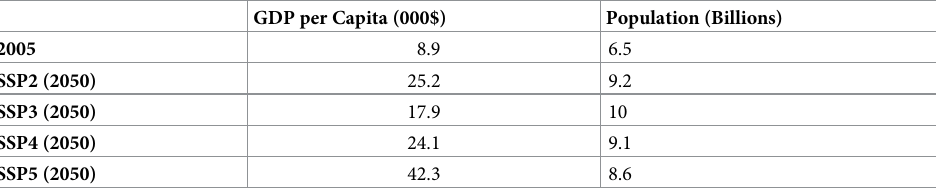
Table 2. Global average GDP per capita and population values for the IMPACT model base year (2005) and four select SSP scenarios. Based on data from IIASA public SSP database